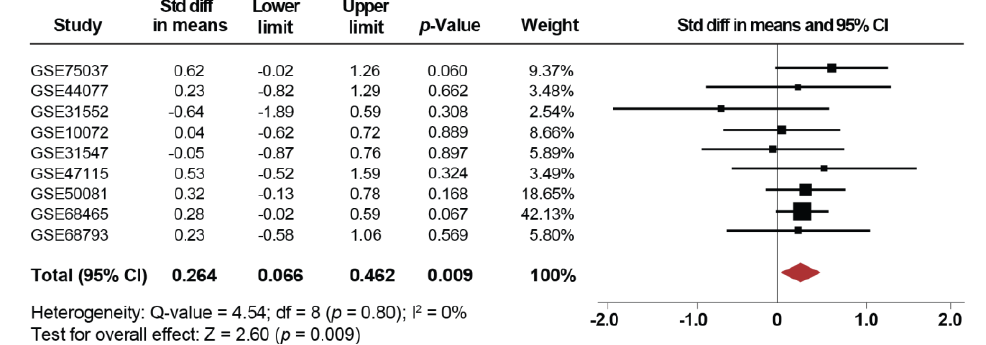
Figure 3. Upregulation of SETDB1 mRNA is correlated with smoking history. ( A ) Forest plot of overall analysis of SETDB1 mRNA expressions between NSCLC patients reported as current smokers compared to non-smoker patients. ( B ) Forest plot of overall analysis of SETDB1 mRNA expressions between NSCLC patients reported as former smokers compared to non-smoker patients. Standardized mean differences (SMD) for each dataset are represented by the squares, and the horizontal line crossing the square represents the 95% CI. The diamonds represent the estimated overall effect.